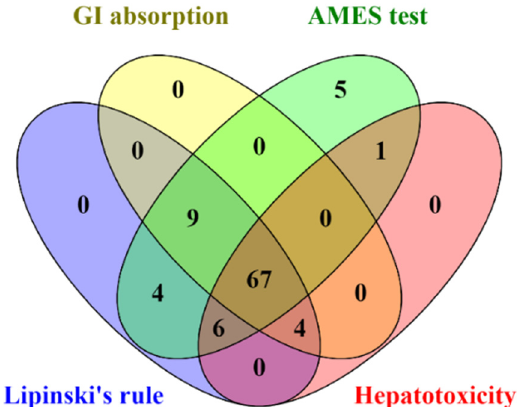
Figure 4. The Venn diagram presents the number of compounds predicted as high GI absorption, no AMES toxicity, no hepatotoxicity, and acceptable for Lipinski’s rule.